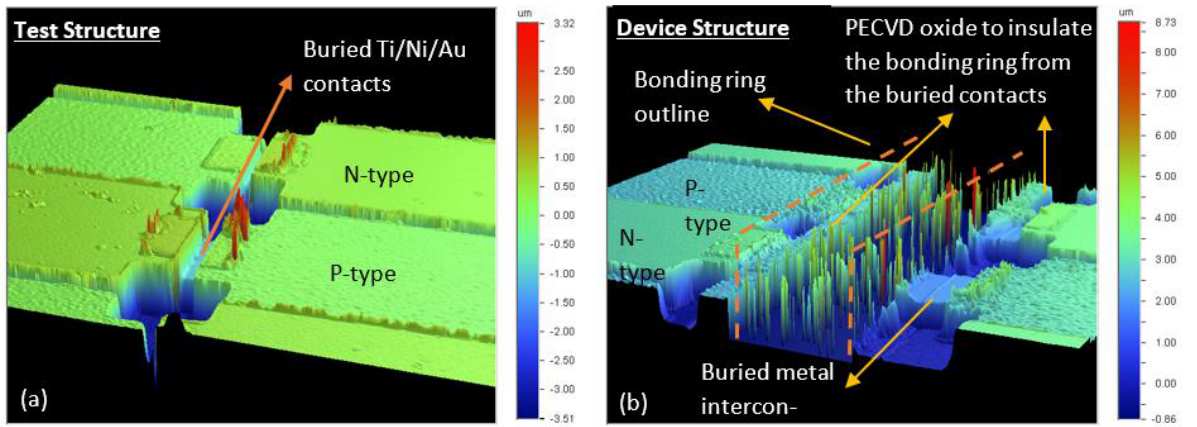
Figure 15. ( a ) 3D profile of a test structure without a bonding ring between each thermocouple-like structure. ( b ) The device structure’s 3D profile illustrates the PECVD oxide on which the bonding ring is deposited to insulate it from the buried metal interconnects connecting the thin films on either side of the bonding ring.